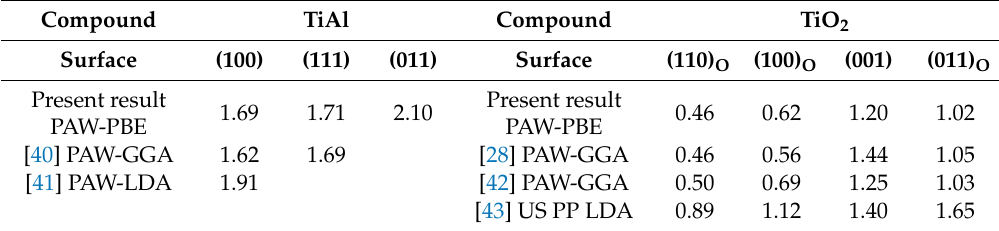
Table 1. Surface energy (in J/m 2 ) of stoichiometric surfaces of γ -TiAl and TiO 2 .